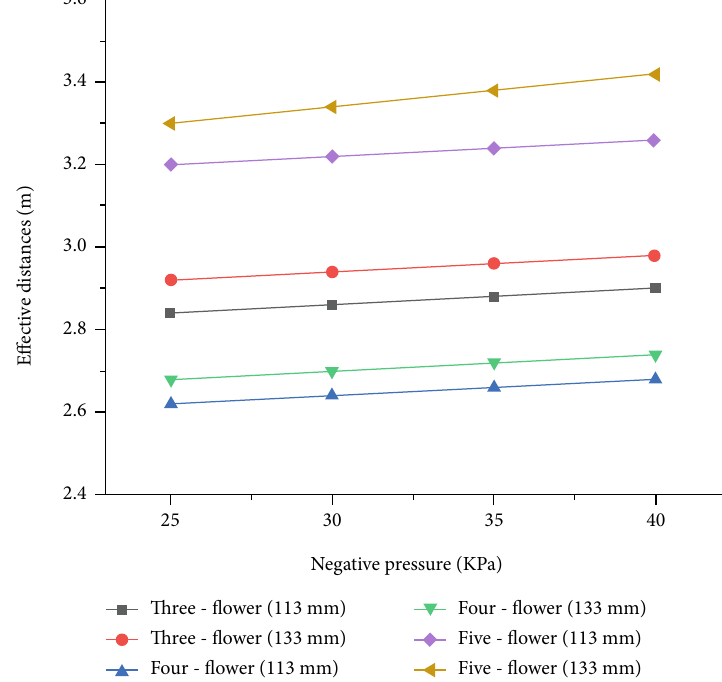
Figure 3: The e ff ective distances between bores under di ff erent suction pressures.